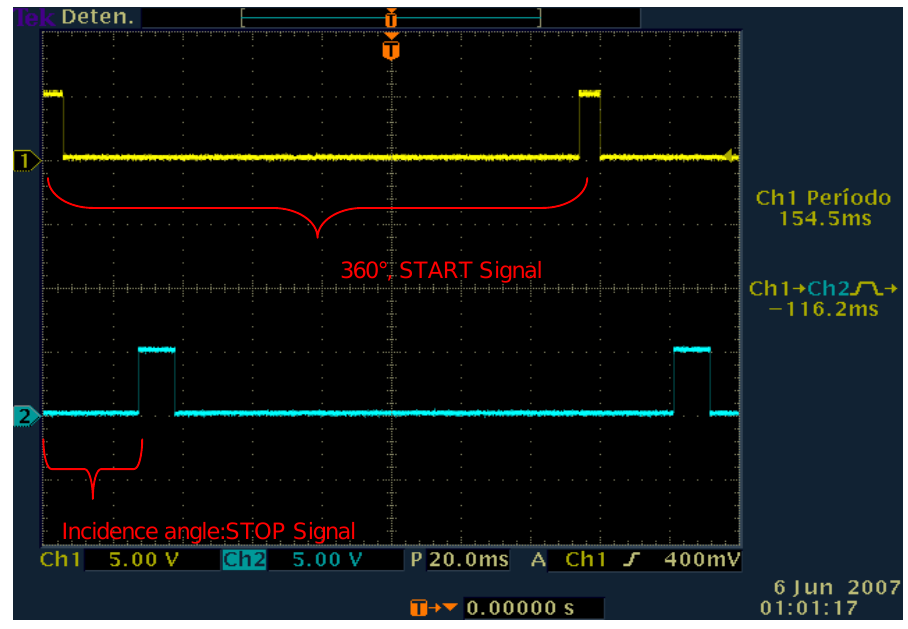
Figure 2. Electric signals generated by POS system on spot and synchronous point